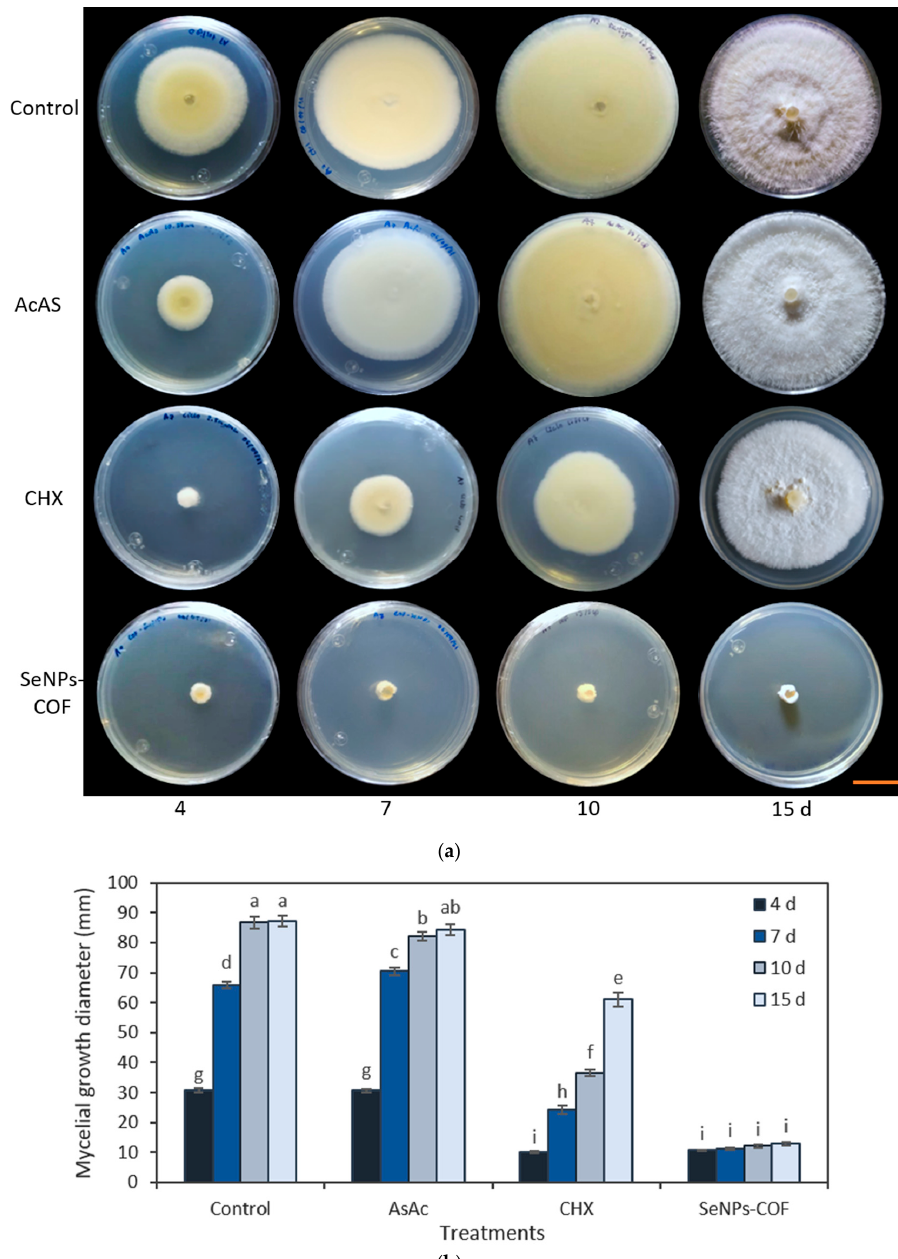
Figure 7. Antifungal activity of SeNPs synthesized with C. officinalis (COF) extracts against C. gloeosporioides . ( a ) Representative photograph of the antifungal activity test under different treatments over time. SeNPs and CHX were applied at 1.7 mg/mL and 2.5 mg/mL, respectively. The scale bar is 2.5 cm. ( b ) Mean comparison of the effect of the SeNPs synthesized with extracts of C. officinalis against C. gloeosporioides . Mean values ± ee. Different letters indicate statistically significant differences according to Duncan’s test ( α = 0.05), p < 0.0001.